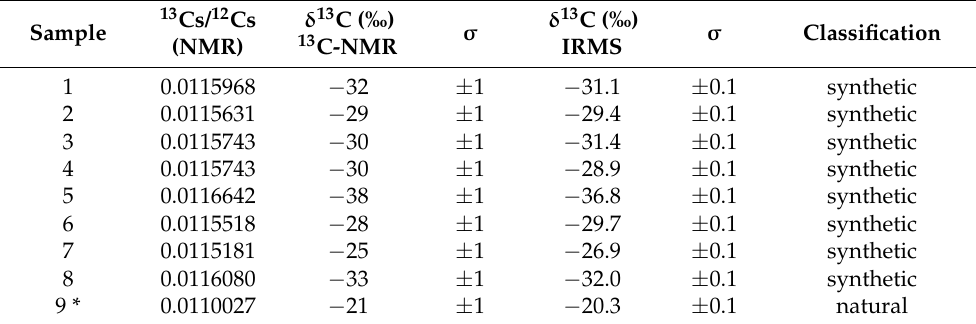
Table 1. Carbon isotope ratio 13 C/ 12 C obtained by 13 C-NMR isotopic analysis and comparison of carbon isotopic values of vanillin samples obtained by 13 C-NMR and IRMS analyses.